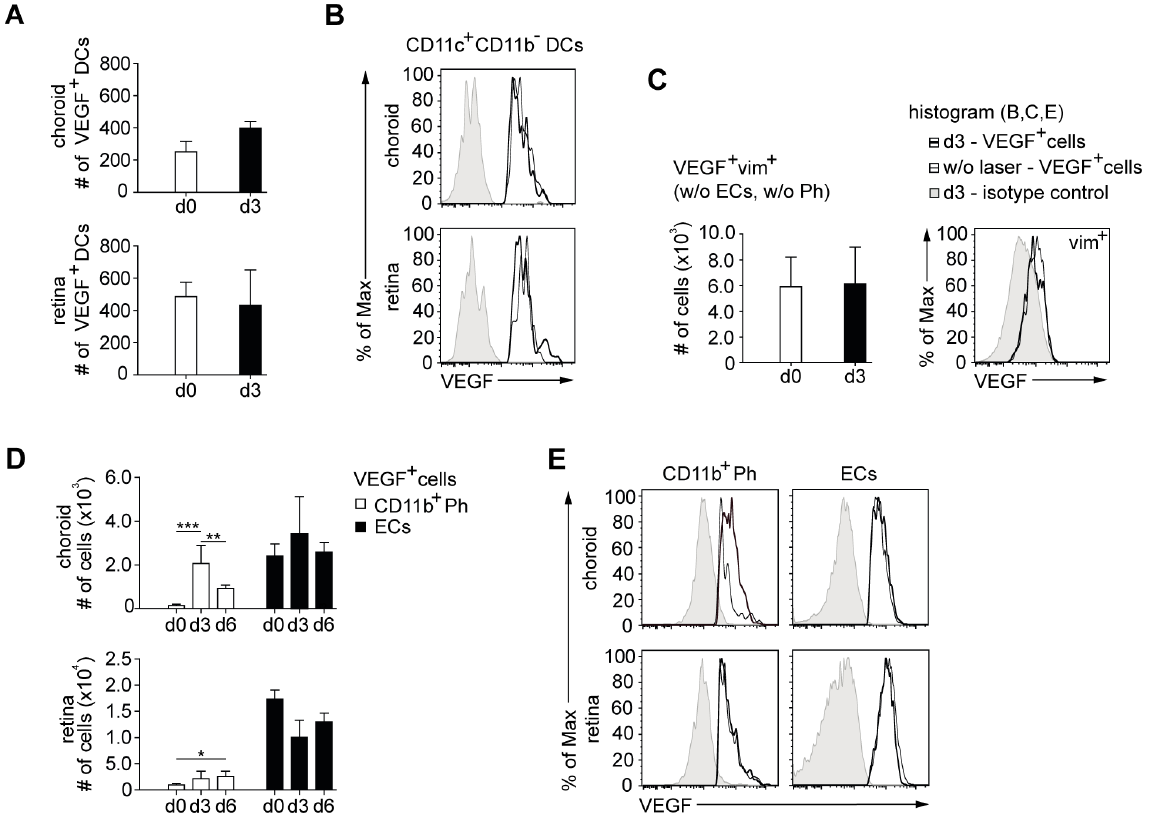
Figure 3. Higher VEGF content in CD11b + phagocytes but neither in other phagocytes nor non-immune cells after laser injury. (A) VEGF + CD11b 2 CD11c + DCs were enumerated in the choroid (top) and the retina (bottom). (B) VEGF content of these DCs without and after laser treatment (histogram). (C) Number of VEGF + astrocytes and Mu¨ller cells (top) and their content of VEGF (histograms). CD31 + ECs and CD11b + CD11c + phagocytes were excluded as shown in Fig. 2F). (D) Analysis of cell numbers for VEGF + ECs and CD11b + phagocytes of the choroid and the retina in untreated eyes and 3 and 6 days after laser injury. (E) VEGF-expression of CD11b + phagocytes and ECs without and after laser treatment in the choroid and the retina. Histograms show VEGF content for cell subsets of untreated eyes (small black line) and 3 days after laser injury (thick black line). The isotype control for the respective cell type in lasered eyes (grey tinted) depicts the background fluorescence. Bar graphs show means 6 SD. Comparisons of cell numbers (D) were performed using one-way analysis of variances (one-way ANOVA) in combination with Bonferroni multiple- comparison post-test. The statistical significance was analyzed as indicated (* , 0.05, ** , 0.01, *** , 0.001). A total of 3–5 mice per group were analyzed in 2 independent